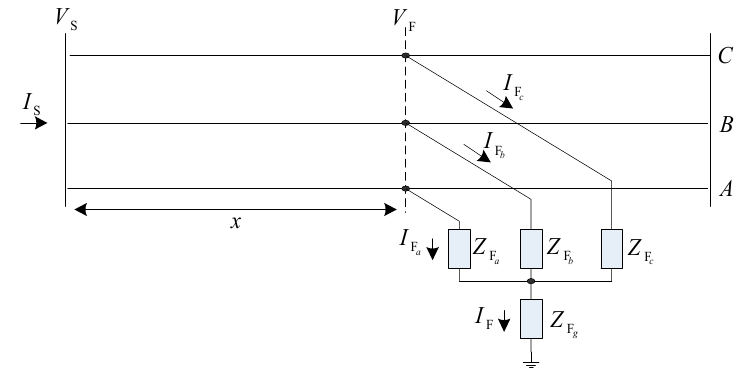
Figure 2. General view of ground faults (single phase, two phase, and three-phase fault to the ground).